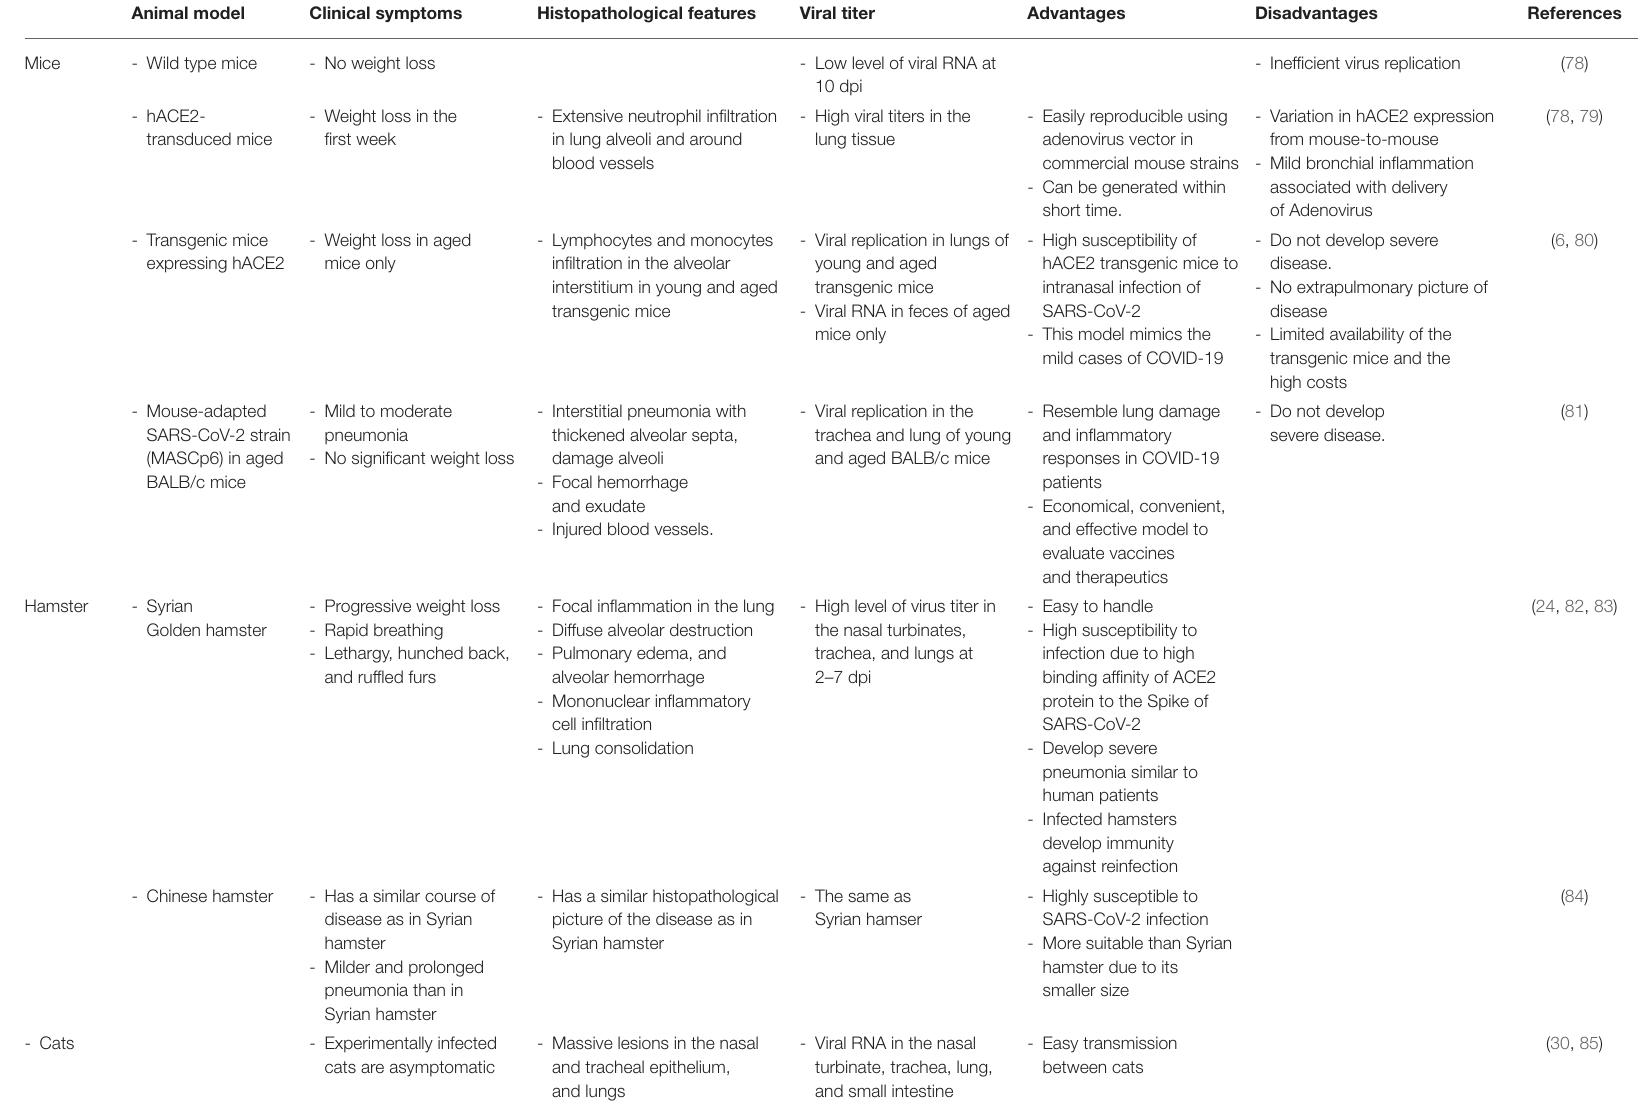
TABLE 1 | The available animal models for